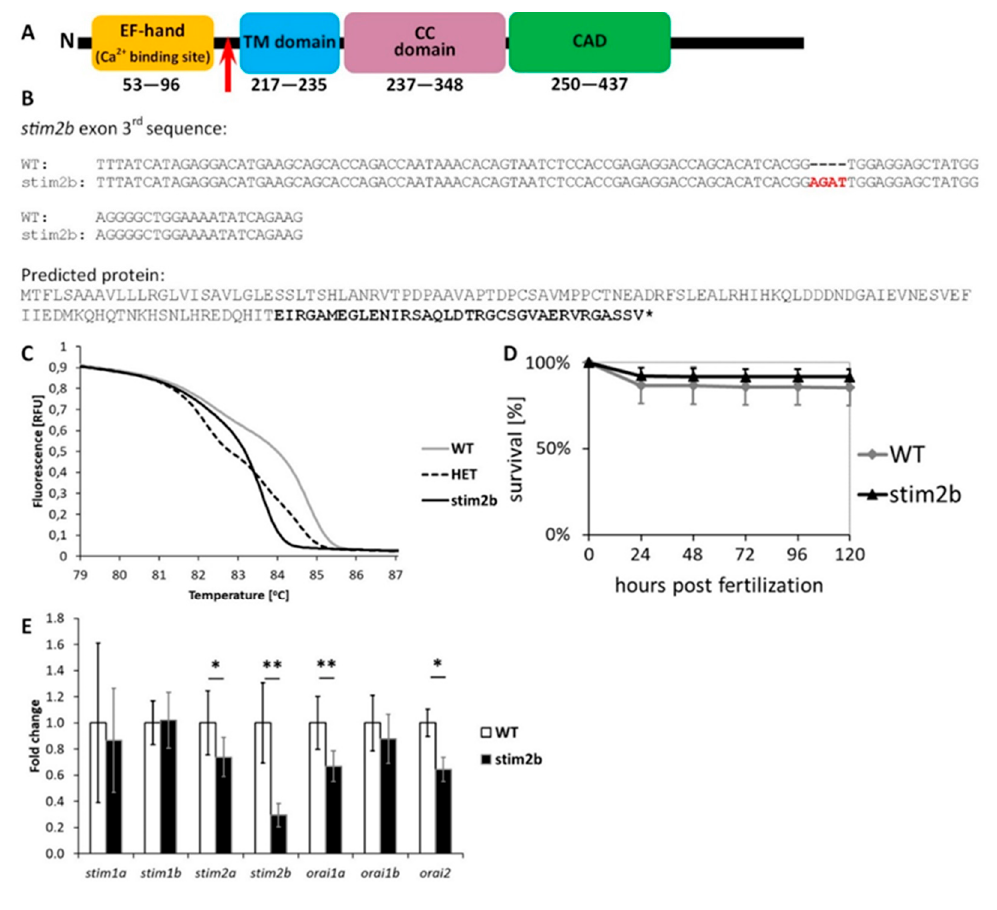
Figure 1. stim2b − / − mutant. ( A ) Schematic illustration of the most important domains of Stim2 protein. The location of the introduced mutation is marked with a red arrow. ( B ) DNA sequence of exon 3 of stim2b in wild-type (WT) and mutant zebrafish (upper) and predicted truncated protein sequence after introducing a frame-shift that cause the mutation (lower). ( C ) Representative results of the high-resolution melting (HRM) analysis that was used to discriminate mutant (stim2b), heterozygous (HET), and WT individuals. ( D ) Survival curve that shows the percentage of surviving WT and stim2b − / − zebrafish throughout the first 5 days of development. Number of experiments: 3, survival of 200 larvae of each genotype was estimated during each experiment. ( E ) RT-PCR results, presented as a mean fold change ± SD. * p < 0.05, ** p < 0.01, *** p < 0.001, mutant vs. WT (Student’s t -test). Number of experiments: 8. Table 3. RNAseq results of the di ff erential expression of genes that are related to the nervous system in stim2b − / − larvae. Student’s t -test was used to compare FPKM-normalized expression values between mutant and WT, and the p values were corrected for multiple testing. * p < 0.05 (FDR < 0.05), ** p < 0.01 (FDR < 0.05), significant di ff erence in fold changes. Number of samples: 4. Number of experiments: